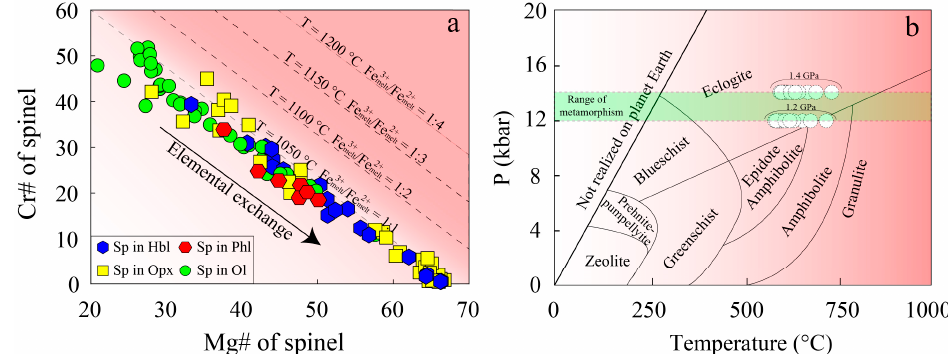
Fig.6 Figure 6. ( a ) Cr-spinel empirical thermometer after Sack and Ghiorso [58]. The equipotential curves and Fe 3+ /Fe 2+ of melt are from Irvine [1] and Agata and Adachi [33]. Equipotential curves shifting to the left represent magmatic differentiation, and the paralleled arrow denotes the trend of elemental exchange. ( b ) Olivine–spinel thermometer after Ballhaus [59]. The compositions for temperature estimates based on the rim of spinel and co-existing olivine. The presupposed pressures (1.2 and 1.4 GPa) are from Wang et al. [39]. Data are available in supplementary material. P–T diagram with eight principal metamorphic facies is from Spear